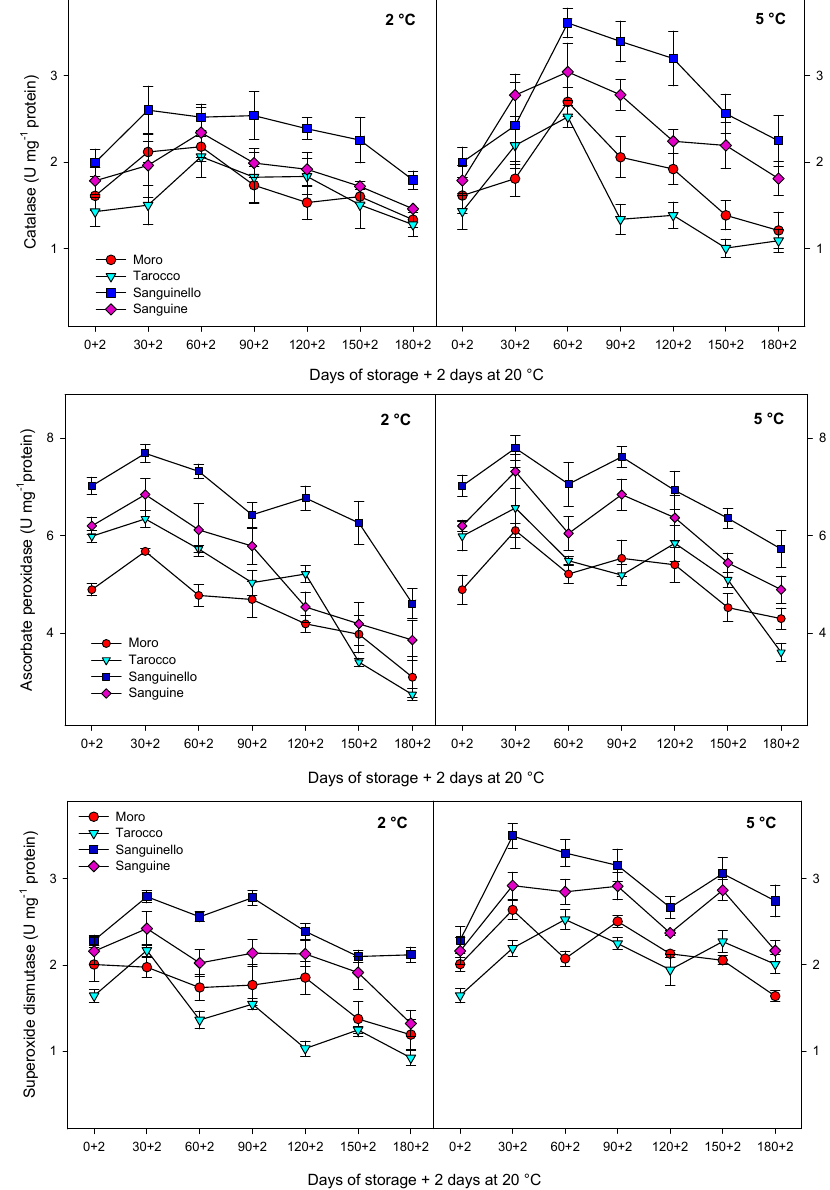
Figure 5. Changes in catalase (CAT), ascorbate peroxidase (APX), and superoxide dismutase (SOD) enzyme activities of blood orange cultivars (“Moro”, “Tarocco”, “Sanguinello”, and “Sanguine”) stored at 2 and 5 ◦ C for 180 days plus 2 days at 20 ◦ C. Vertical bars represent ± standard error (SE) of means. LSD ( p < 0.05) values are 0.69, 1.04, and 0.30, for CAT, APX, and SOD,